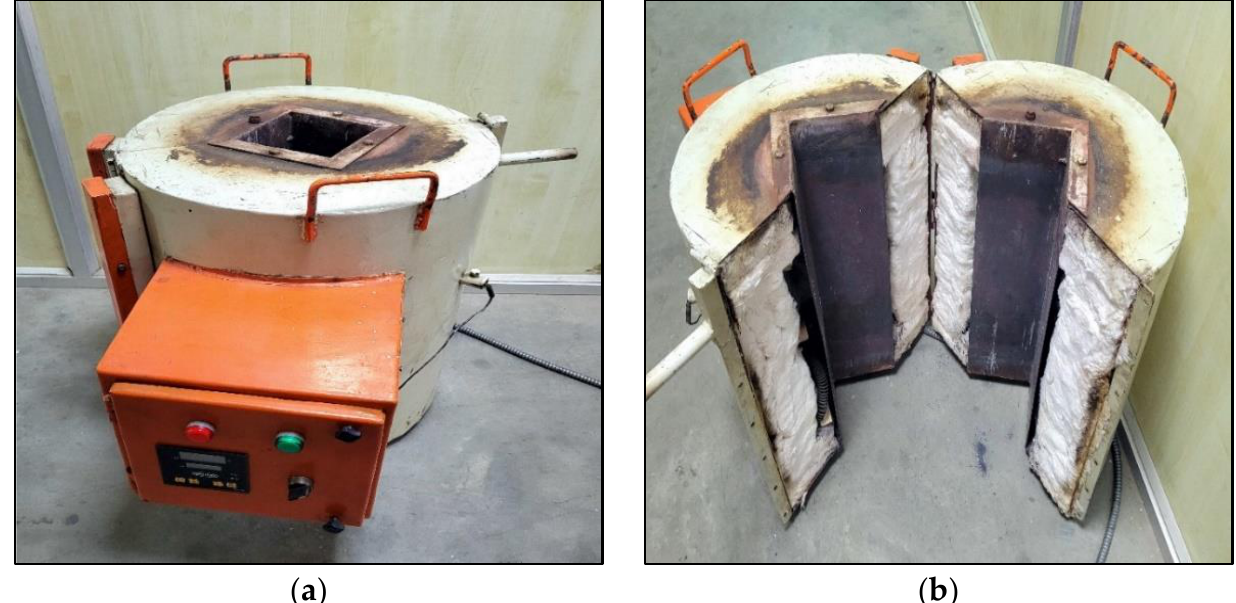
Figure 7. High-temperature localized heating element. ( a ) Overall view. ( b ) Open view.